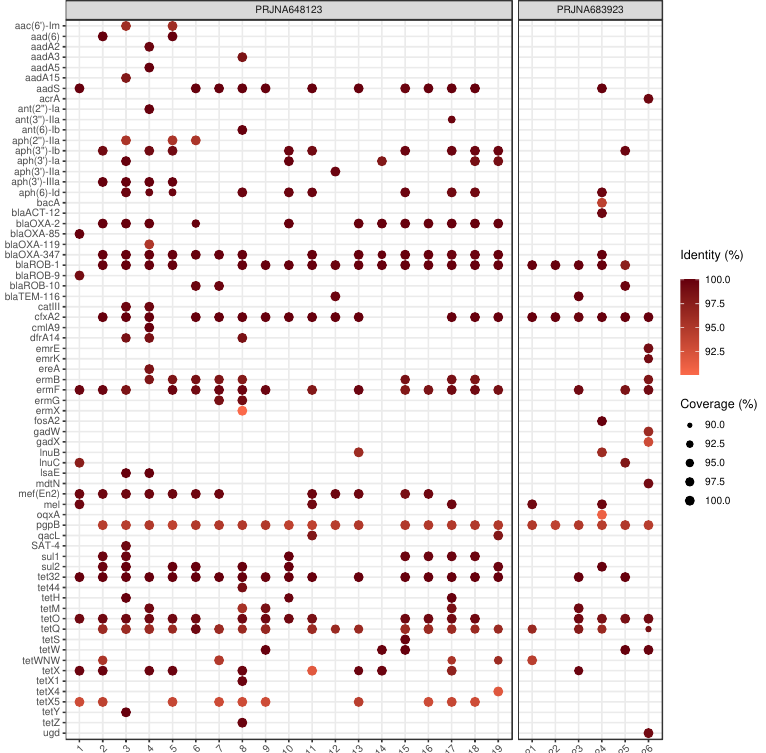
Figure 2. Identifed ARGs by samples. For each sample–ARG combination, only the best finding is plotted. The size and the color of the dots correspond to the coverage and the sequence identity of hits on reference genes, respectively. In sample No. 20, there was no identifiable ARG. The gene names that are too long are abbreviated ( acrA : E. coli acrA ; emrE : E. coli emrE